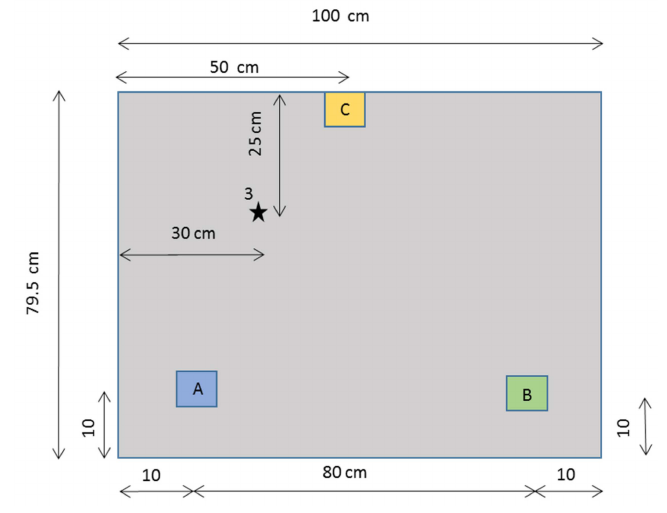
Figure 12. Scheme for Case Study 3.